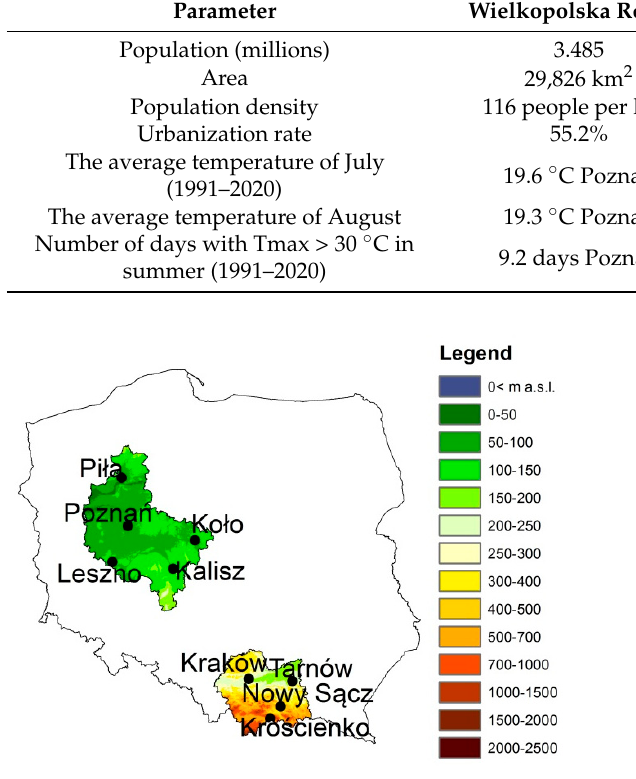
Figure 1. Location and topography of the analyzed regions.